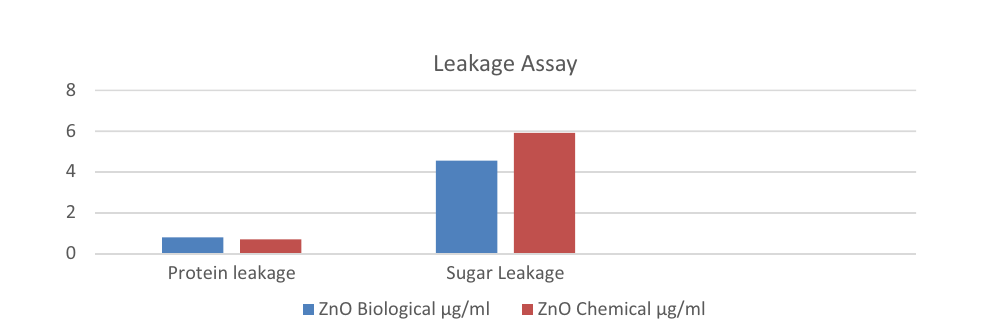
Figure 8. Comparative protein and sugar leakage assay under treatment of ZnO nanoparticles of E. coli .